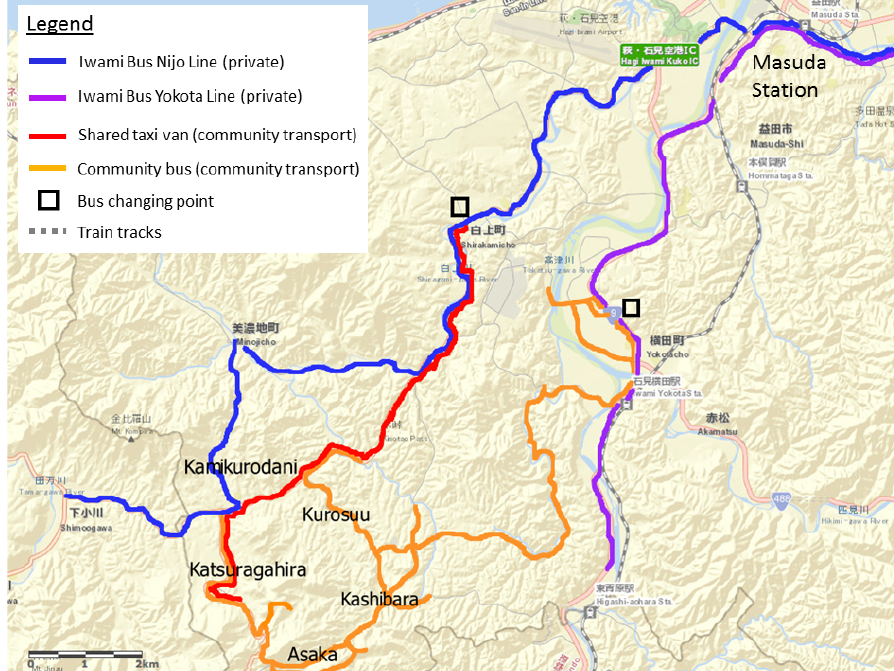
Figure 1. Map of Bus links between Nijo and Masuda City Centre. Source: Authors using ArcGIS basemap (Esri Japan, Esri, HERE, Garmin, INCREMENT P, NGA, USGS (c) Esri Japan).